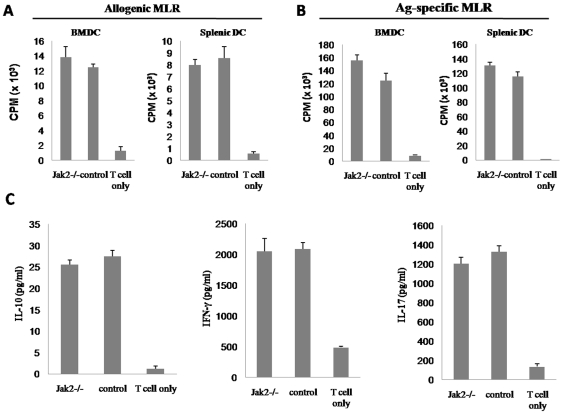
DCs deficient for Jak2 show similar potency to stimulate T cell activation.(A) Allogenic MLR results. (B) Antigen-specific MLR results. (C) ELISA analysis of cytokines produced by the activated T cells. MLR were carried out using either BALB/c T cells (allogenic) or OT-1 T cells (antigen-specific) as responders in the condition of DC/T ratio 1∶10. T cell proliferation was estimated by 3H thymidine incorporation. Data shown in the figure are mean ± SE of three independent experiments performed.